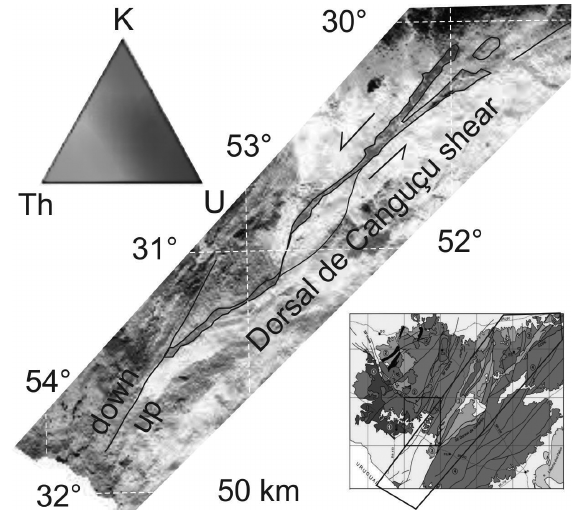
Figure 6 - Selected example of application of total K + eU + eTh signal to describe the Dorsal de Canguçu shear. For interpretation of the references to color in this fi gure legend, the reader is referred to the web version of this article.